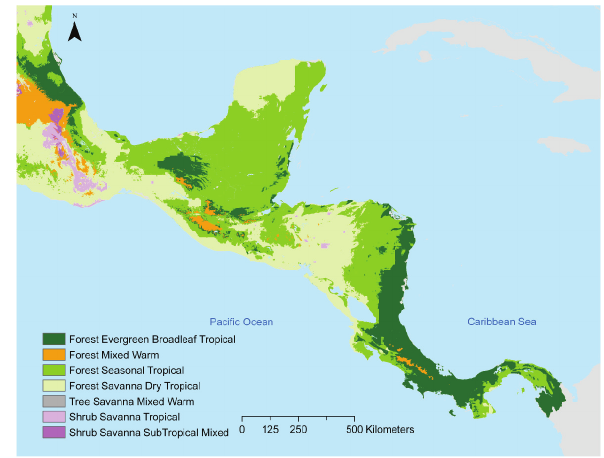
Fig. 11. Potential vegetation types of Mesoamerica modelled by